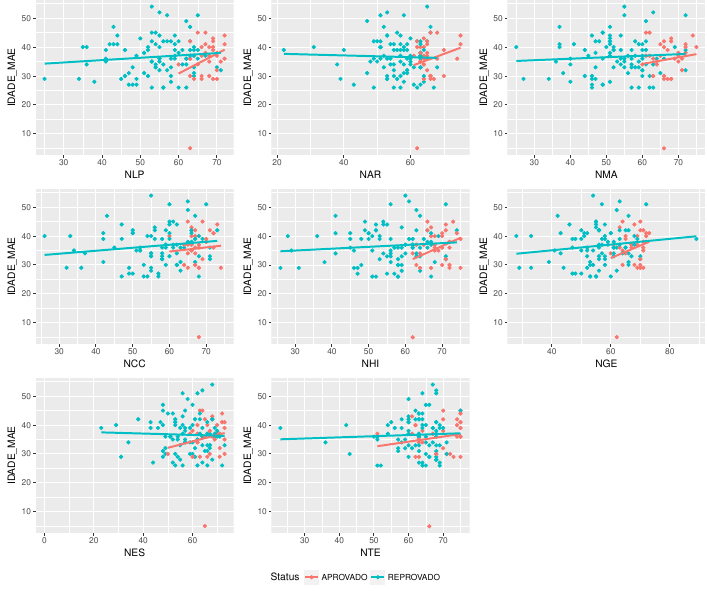
Figure 13. The correlation between discipline’s grade and mother’s